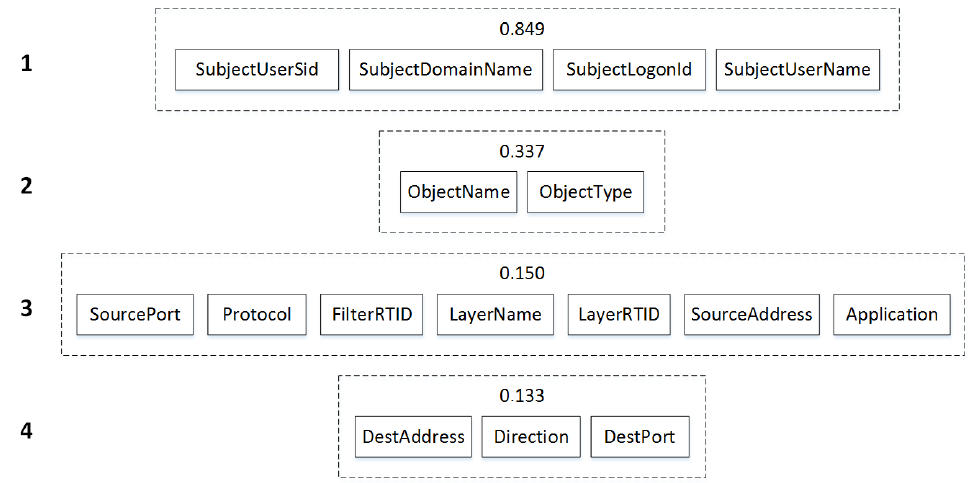
Figure 12. Property groups describing object